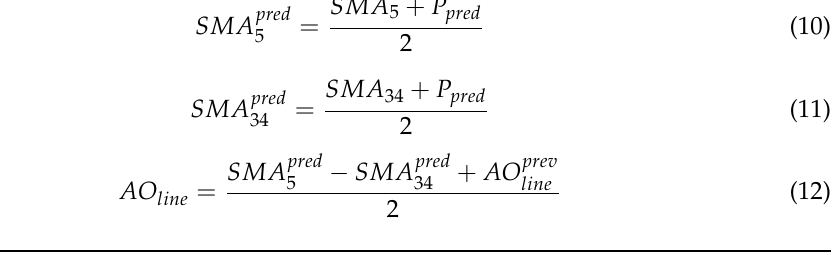
Algorithm 4 Awesome Oscillator using stochastic neural networks.